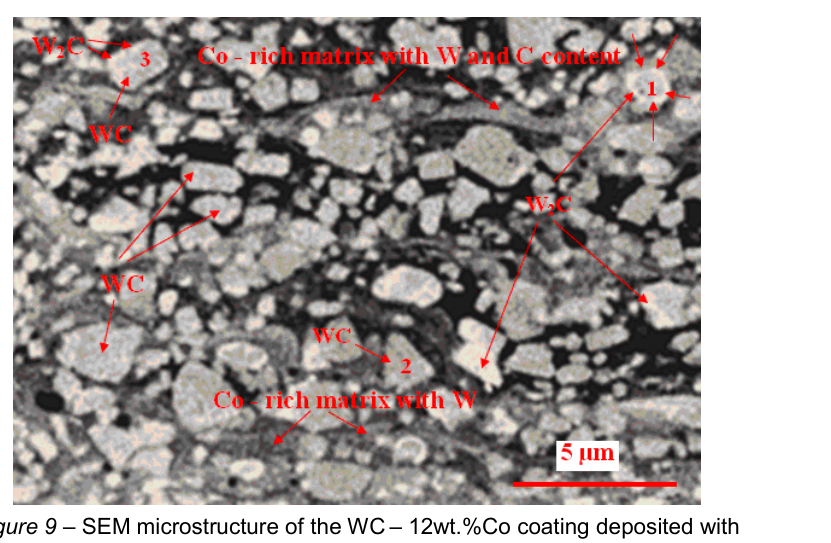
Figure 9 – SEM microstructure of the WC – 12wt.%Co coating deposited with a helium feed rate of 32